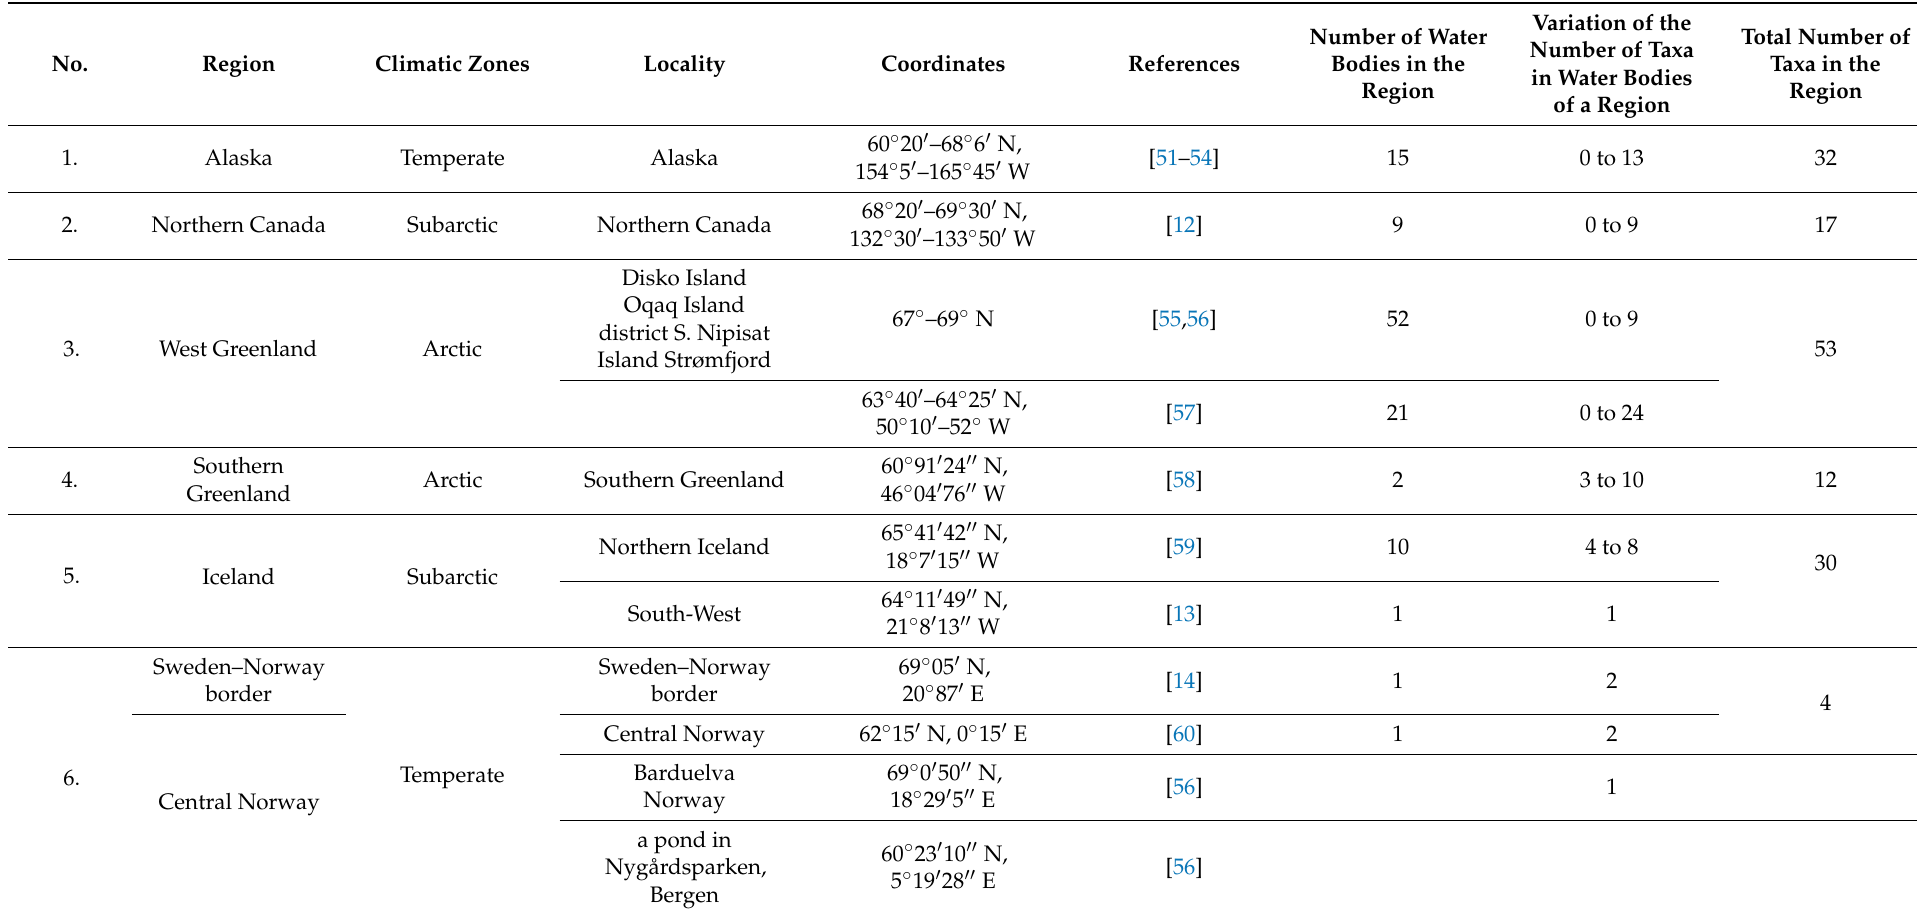
Table 1. Regions above the 60th parallel north, in which silica-scaled chrysophytes have been